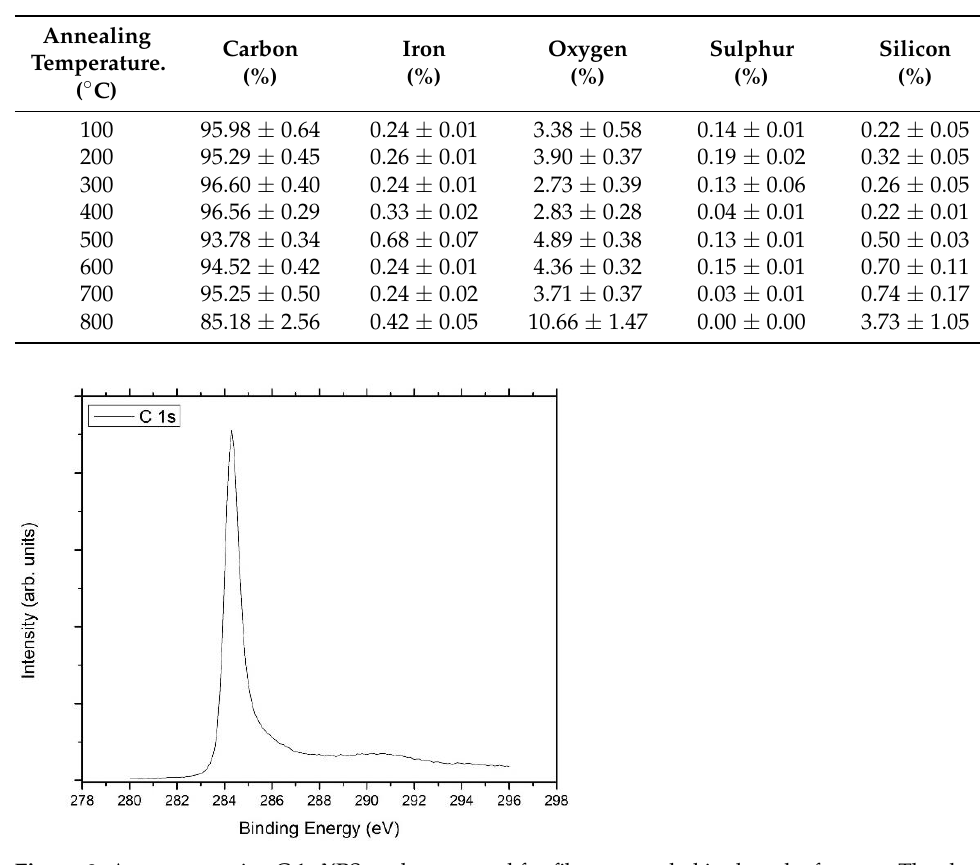
Figure 8. A representative C 1s XPS peak measured for fibers annealed in the tube furnace. The shape of the C 1s peak did not change with annealing temperature all the way to 800 °C.